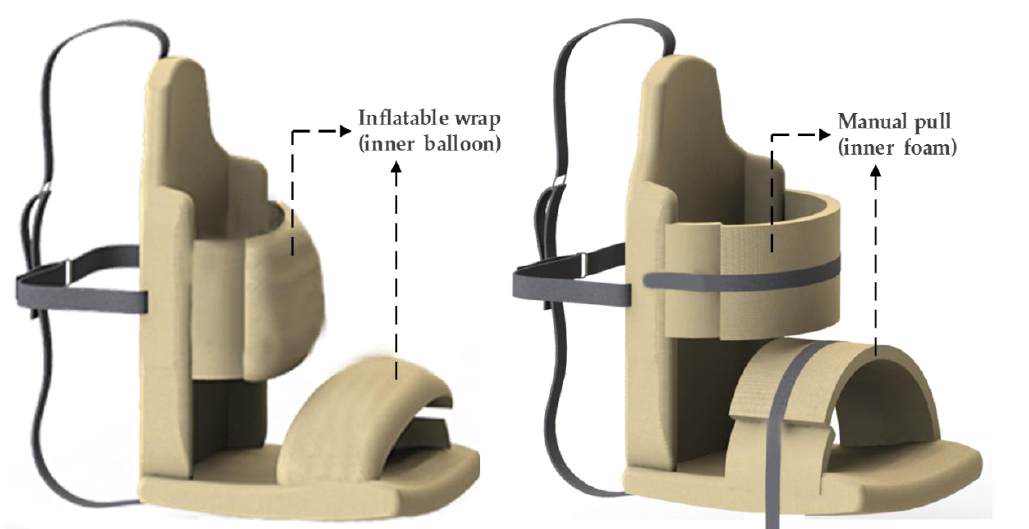
Figure 1. Model of AHMPS inflatable wrap ( left ) and manual pull ( right ).